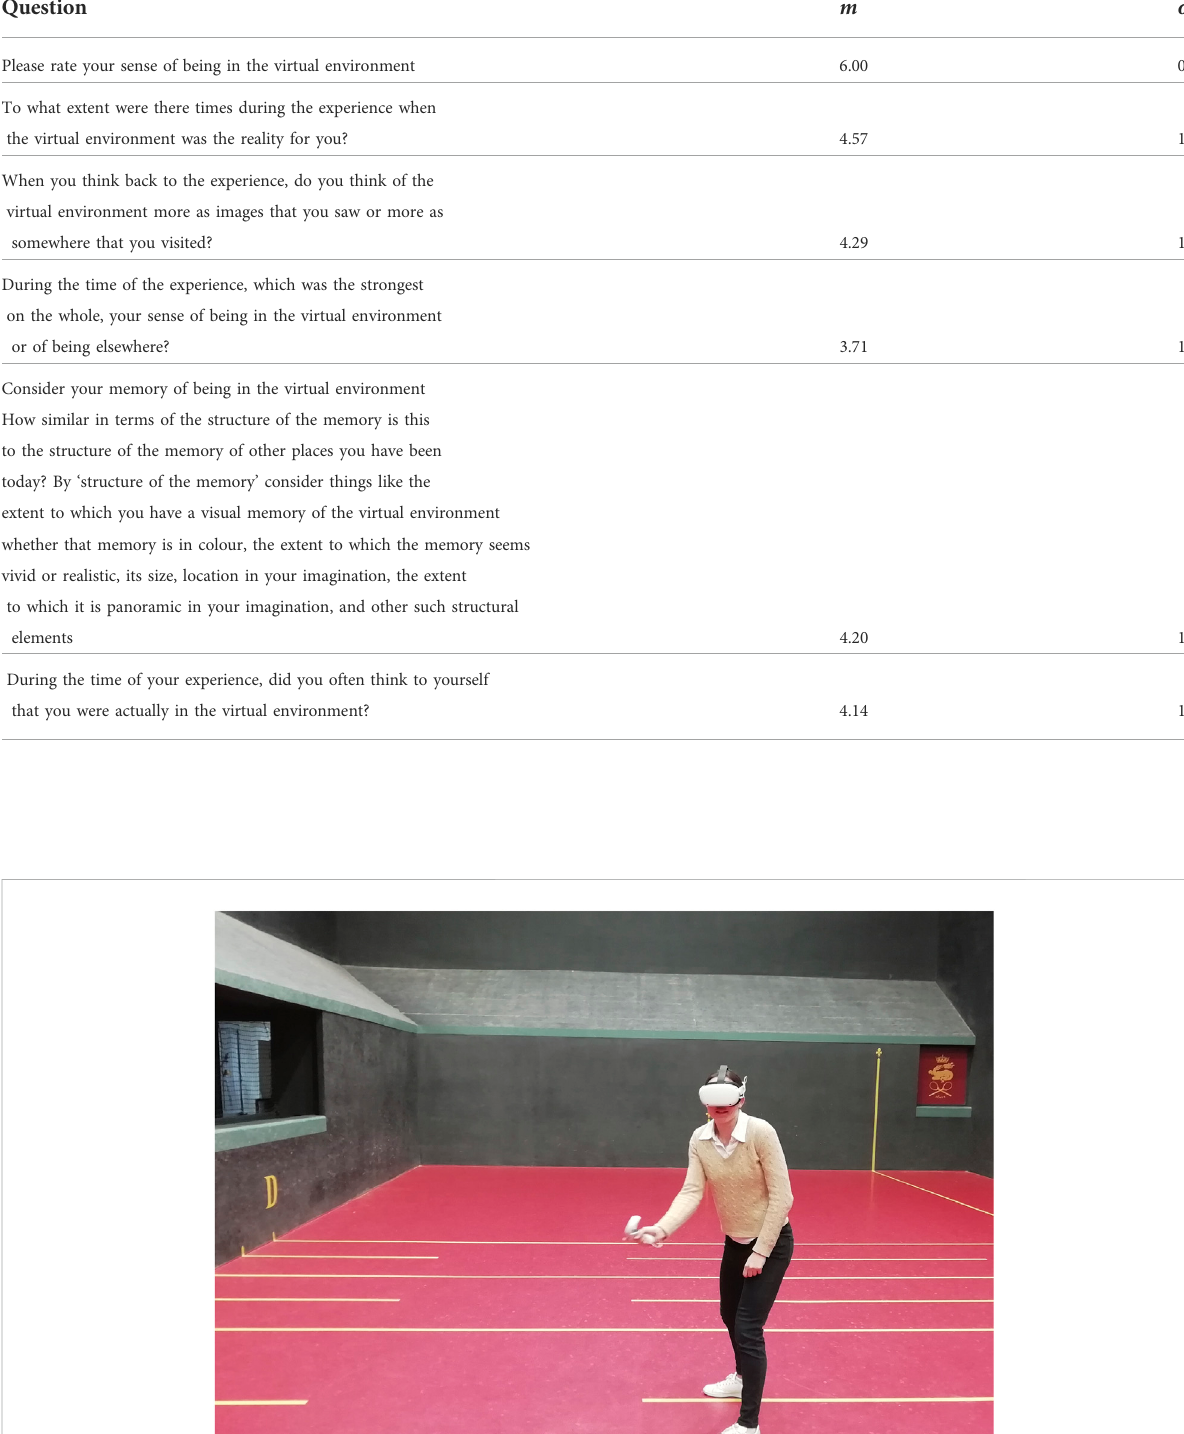
TABLE 3 Results of the Slater-Usoh-Steed (SUS) questionnaire. Question m σ